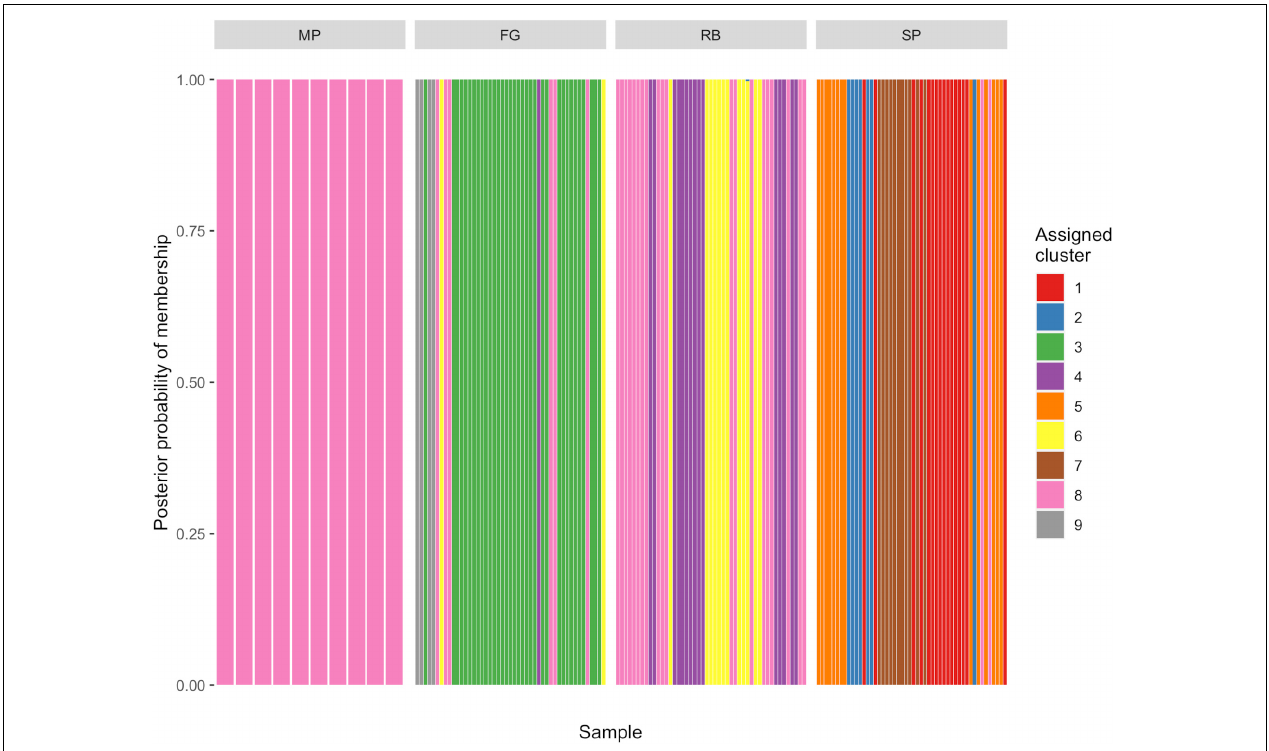
FIGURE 6 | Discriminant analysis of principal components (DAPC) genotype composition plot showing probability of membership of each Leptographium wageneri var. pseudotsugae isolate haplotype in each of nine clusters assigned with K-means clustering